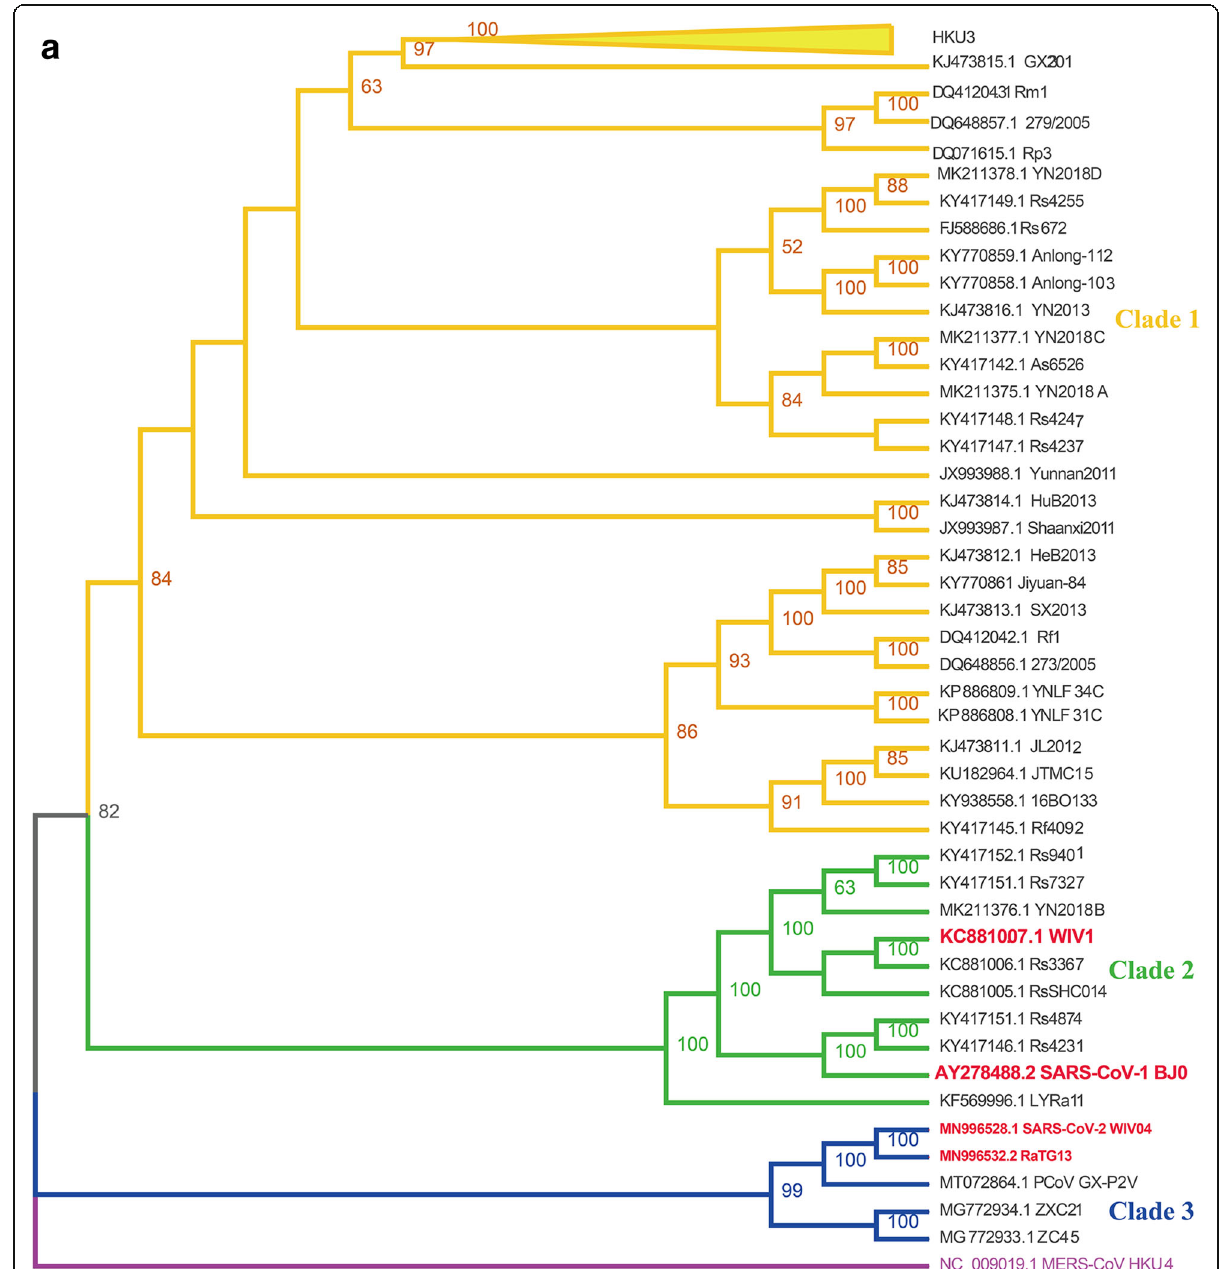
Fig. 3 Spike gene analysis of bat SARSr-CoVs. a Phylogenetic tree of bat SARSr-CoVs S full-length sequences from NCBI database. Three different clades were shown. Bat MERS-related HKU4-CoV was used as outgroup. b Alignment of bat SARSr-CoVs receptor-binding motif (RBM) in spike protein. The residue numbers refer to corresponding regions in SARS-CoV-1 or SARS-CoV-2. Please refer to ( a ) for accession number or clade information for each viral strain. Dashes indicated residues absent. SP, signal peptide; NTD, N-terminal domain; FP, fusion peptide; HR1, heptad repeat 1; HR2, heptad repeat 2; TM, transmembrane domain; CP, cytoplasmic